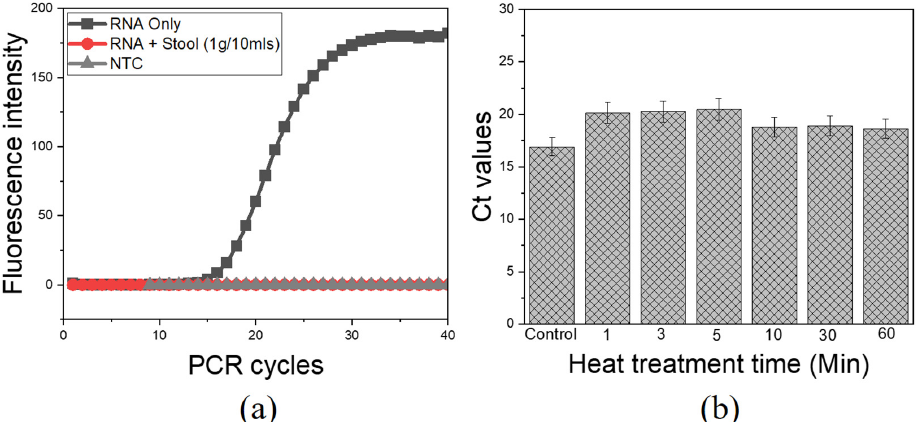
Figure 3. PCR inhibitors and the effect of heat treatment for direct RNA detection from stool samples. An aqueous phase qPCR using ultra ‐ fast real ‐ time PCR (G2 ‐ 4) System; ( a ) Complete PCR inhi ‐